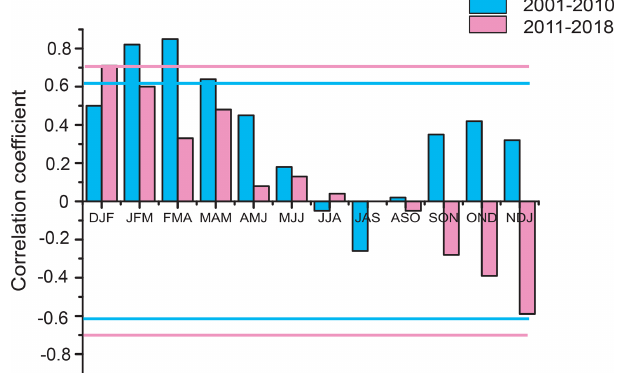
Figure 7. Correlation between the seasonal NAO index and the April–June North Atlantic difference index (NADI) for 2001–2010 and 2011–2018. The blue and pink horizontal lines indicate the 95% confidence levels for 2001–2010 and 2011–2018,